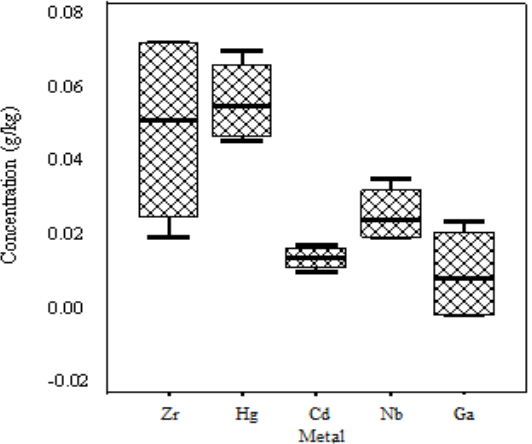
Figure 3. Statistics of Zr, Hg, Cd, Nb and Ga content in